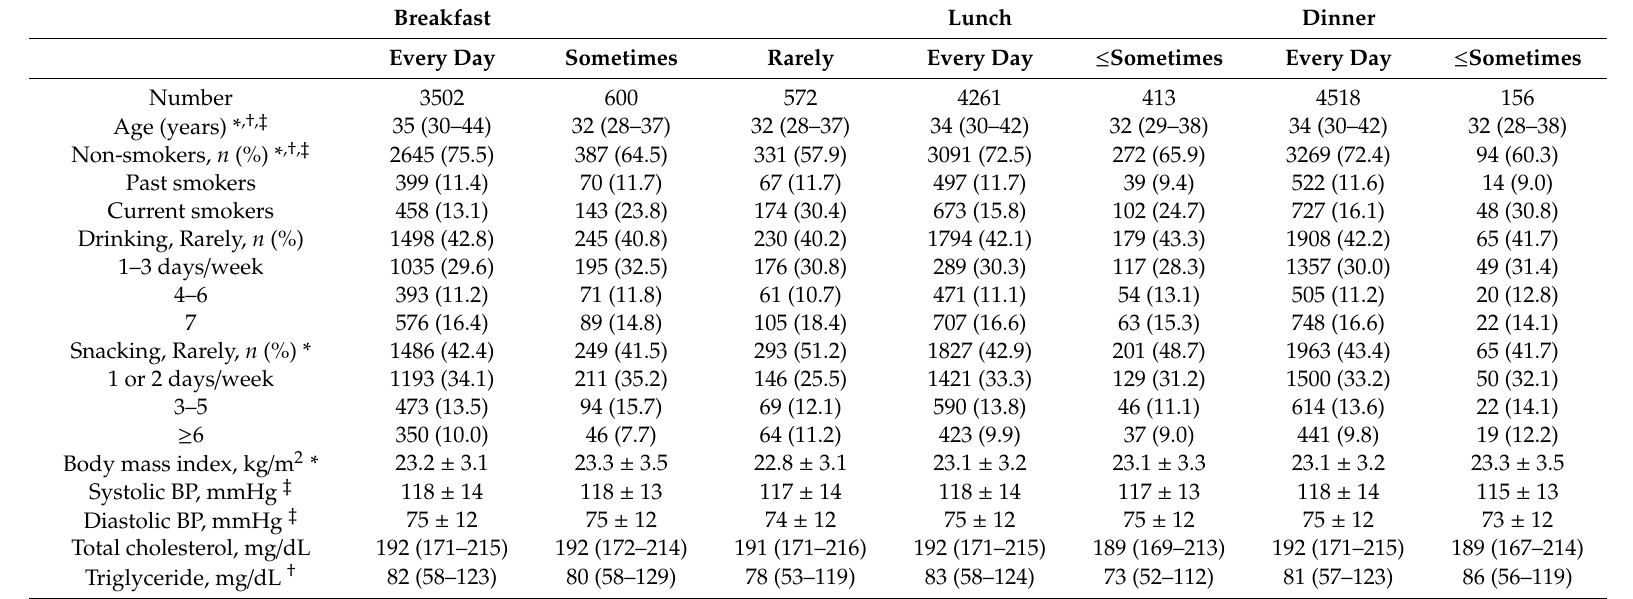
Table 2. Baseline characteristics stratified by the frequency of breakfast, lunch, and dinner in 4674